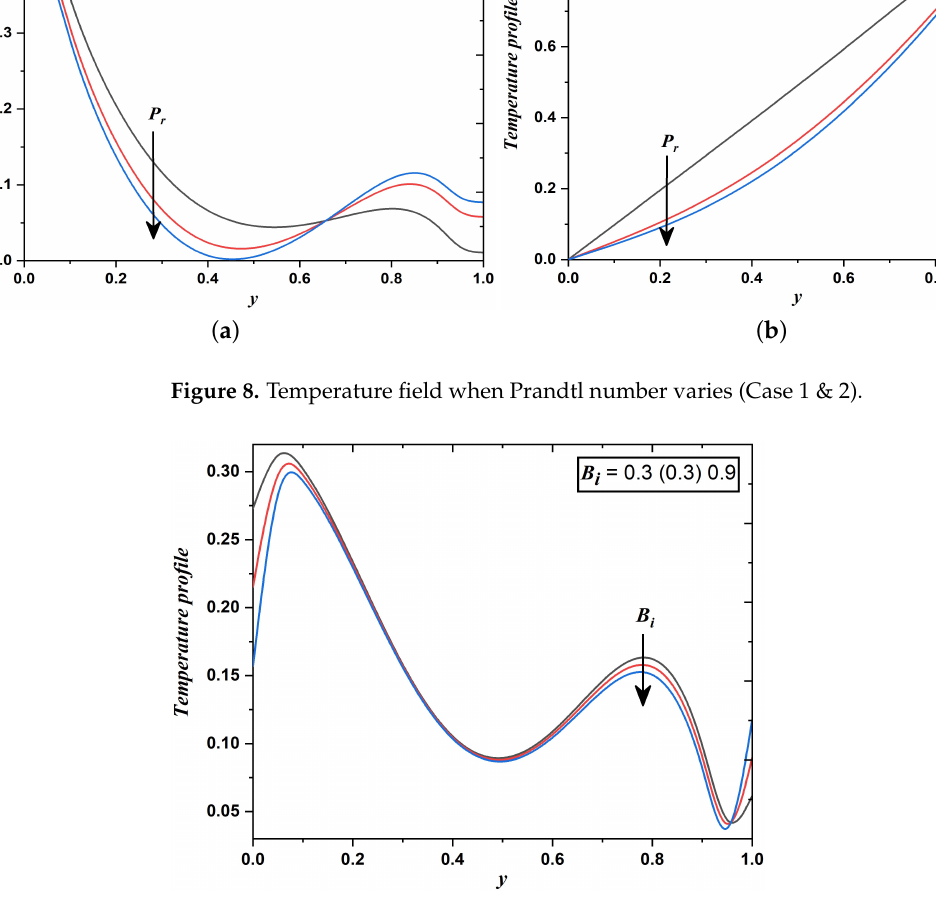
Figure 9. Temperature field when Biot number varies (Case